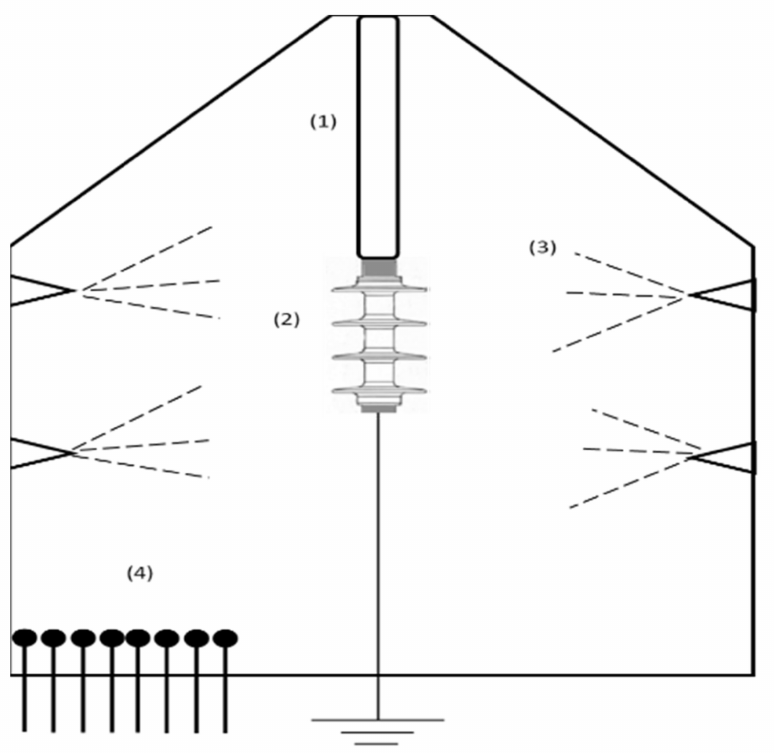
Figure 1. Schematic view of the fog chamber. ( 1 ) Voltage supply conductor, ( 2 ) Test insulator, ( 3 ) Nozzles, and ( 4 ) Fog control panel.